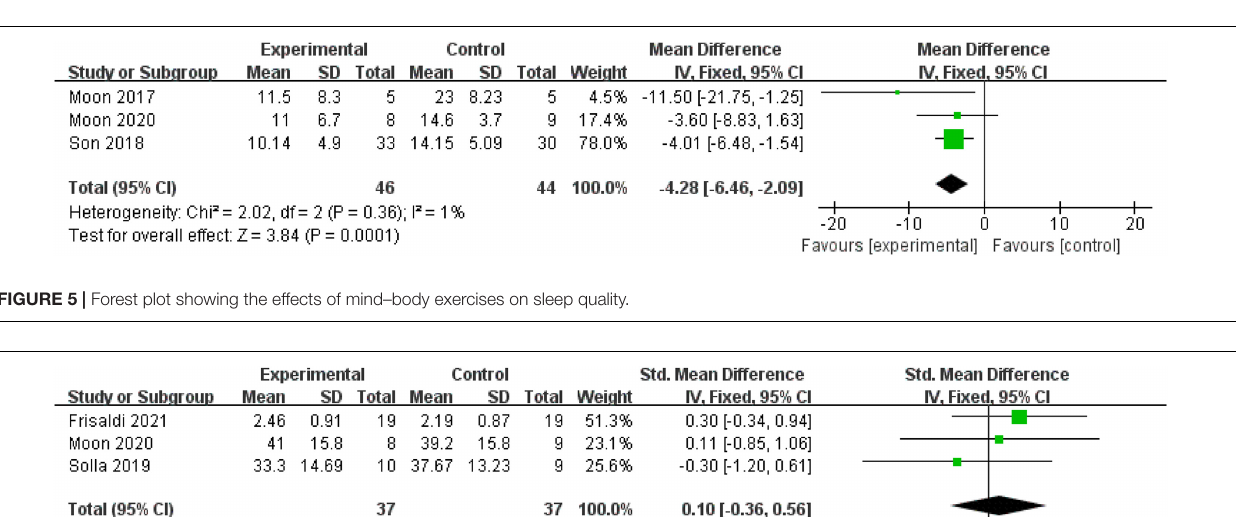
FIGURE 4 | (A) Forest plot showing the effects of mind–body exercises on global cognitive function. (B) Forest plot showing the effects of mind–body exercises on global cognitive function in subgroups stratified according to the dose of the intervention. (C) Forest plot showing the effects of mind–body exercises on global cognitive function in subgroups stratified according to the different durations of the intervention.